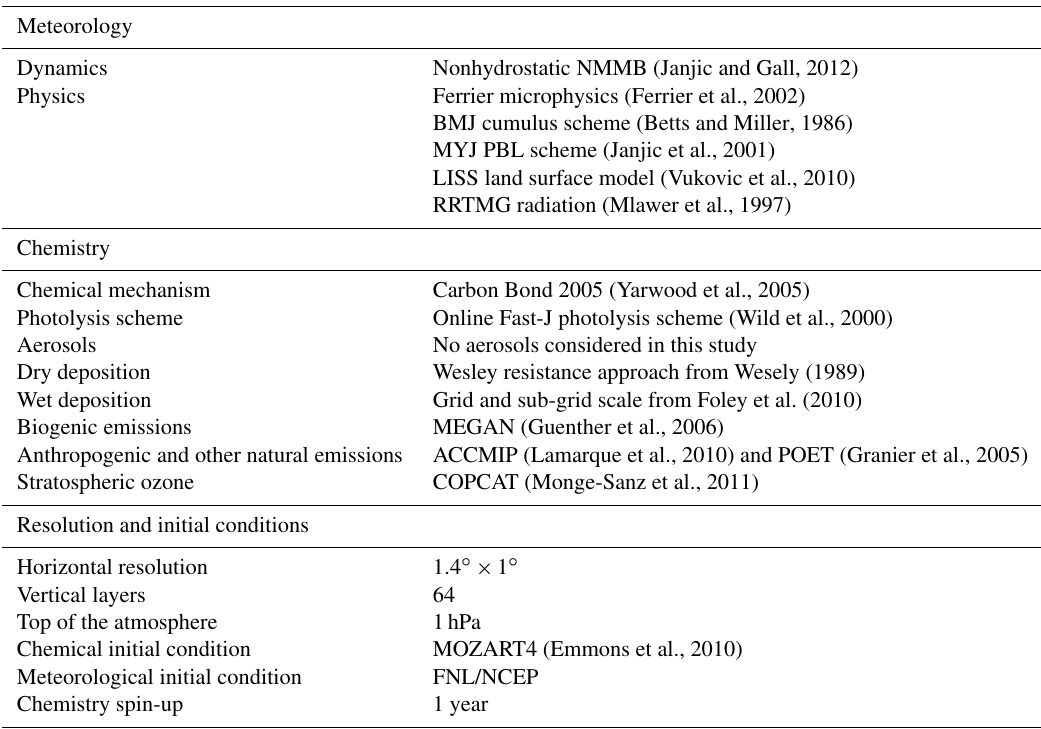
Table 1. Model characteristics and experiment